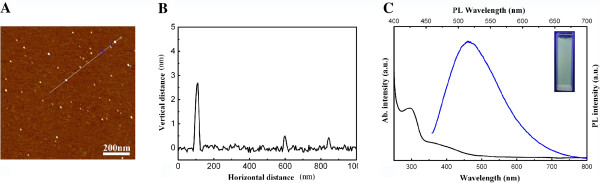
Image, analysis, and spectra of C-dots-NH2. (A) TM-AFM image of C-dots-NH2. (B) The section analysis selected the site in (A) labeled with a white line. (C) UV absorption and photoluminesecence spectra of C-dots-NH2 in pure water, the inset of the photography excited at 302 nm with an 8-W UV light.